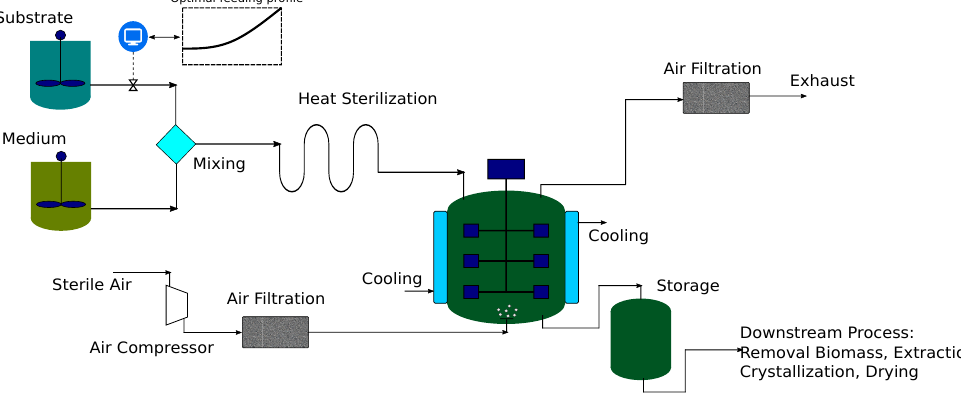
Figure 11. Scheme of a fermentation process with a fed-batch